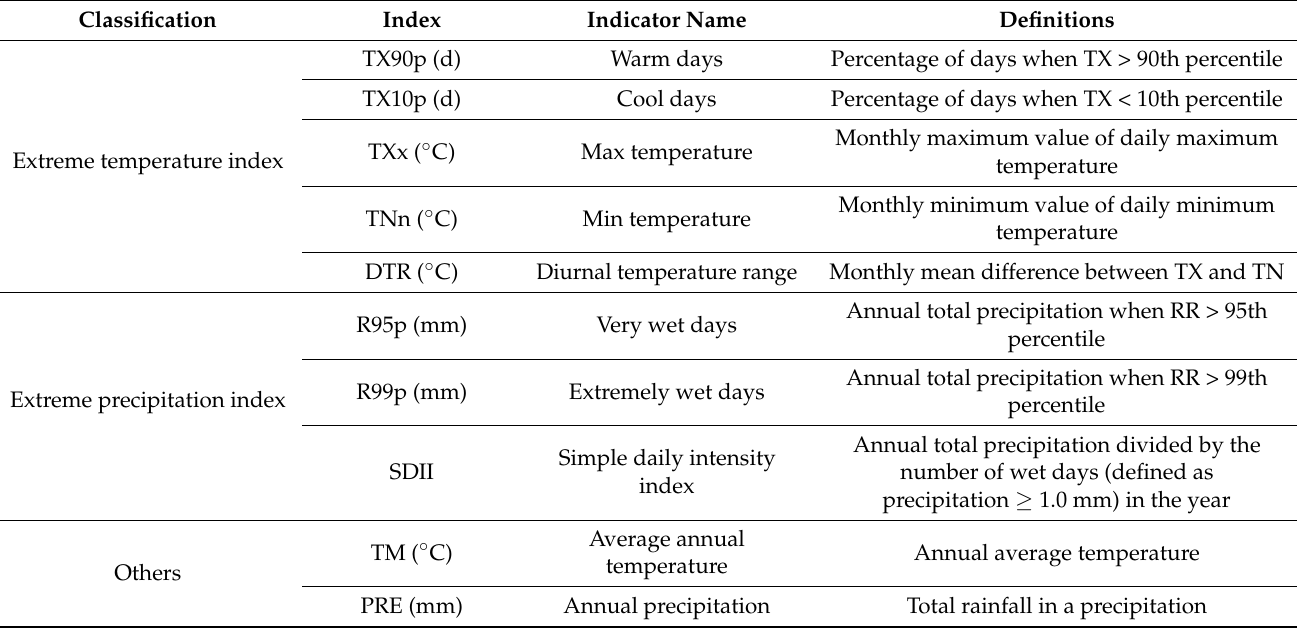
Table 1. Selection and definition of extreme climate